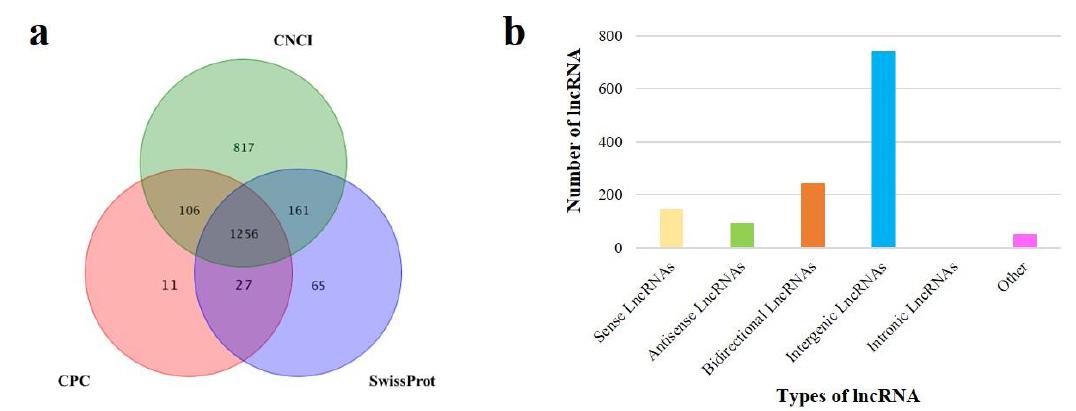
Figure 2. New lncRNA identification and classification. ( a ) The novel lncRNAs were identified by three predicted software CNCI, CPC and SwissProt. ( b ) The number statistics of different types of new lncRNAs.